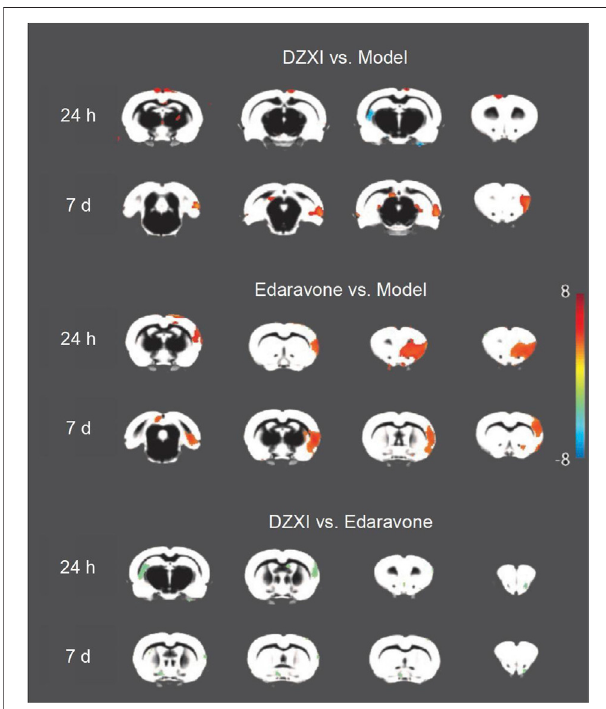
FIGURE 4 | DZXI treatment increased grey matter volumes in speci fi c brain regions of MCAO rats. Due to image quality, one rat was removed from themodelgroupandtworatswereremovedfromtheedaravonegroup. n (cid:2) 11 inthemodelgroup,12intheDZXIgroup,and10intheedaravonegroup. Thechangesingreymattervolumesamonggroups(modelgroup,DZXIgroup and edaravone group) at 24th h and 7th day of treatments. The brain regions withsigni fi cantdifferencesinvolume among different groupsand time pointse were identi fi ed by ANOVA analysis performed on the grey matter density map in SPM12. Further pairwise comparisons between groups at each time point were performed using multivariate analysis of variance (MANOVA). The regionswithsigni fi cantchangesinvolume(Alphasim-corrected p < 0.05)were markedinbrainmaps.DZXIprotectedsomeregionsinthebilateralneocortex, the right entorhinal cortex, the left perirhinal cortex, the left subiculum and the right frontal association cortex. Edaravone protected some regions in the bilateral neocortex and the olfactory bulb. When compared DZXI and edaravone, a larger volume of the left neocortex was observed in the DZXI group, while larger volumes of the right olfactory bulb, the right neocortex and the left hippocampus were observed in the edaravone group.